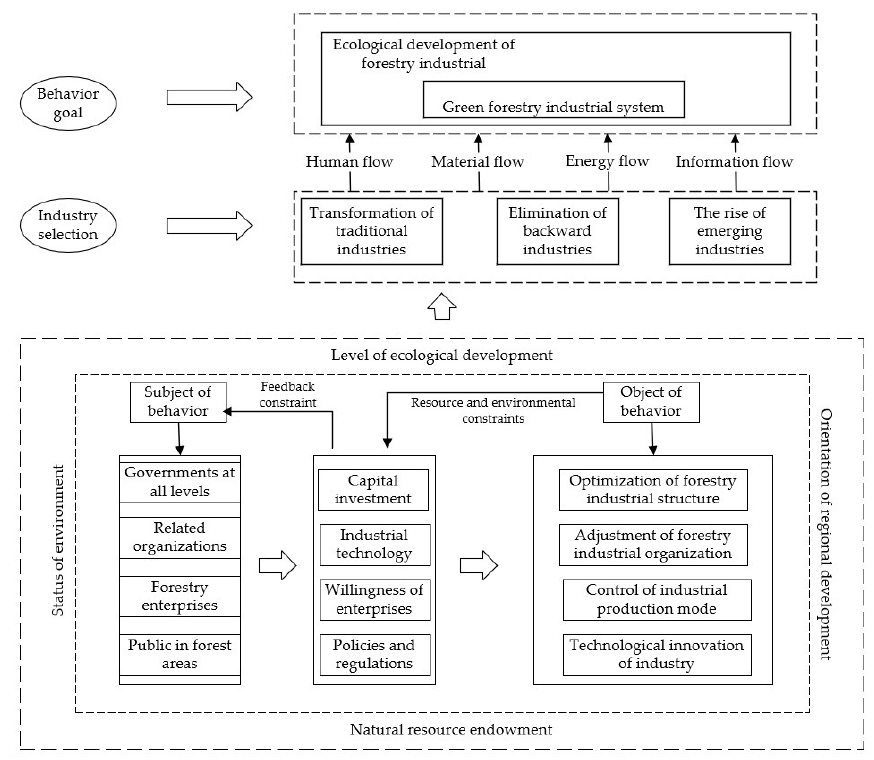
Figure 2. Theoretical model of ecological development in the forestry